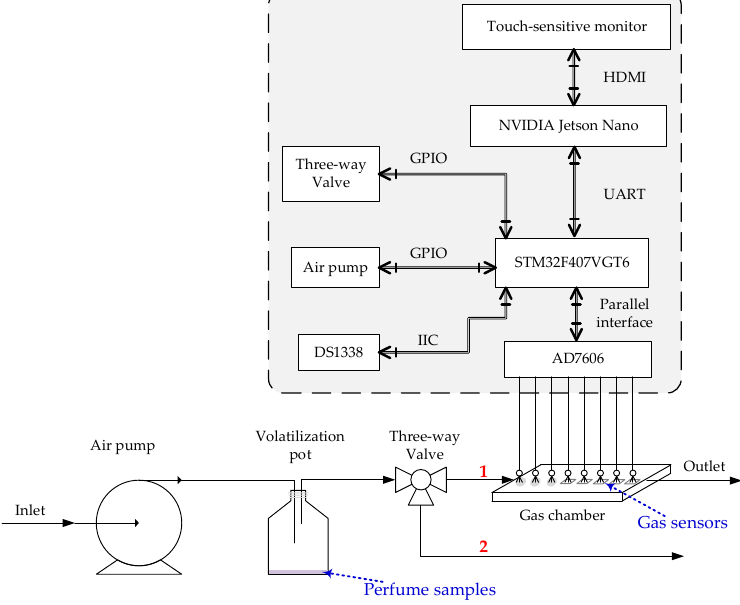
Figure 1. Architecture of the SMUENOSEv2 [3]. The components outside and inside the dashed round rectangle are gas route and electronic components, respectively. The red bold numbers 1 and 2 stand for two sub-routes at the downflow side of the three-way valve.